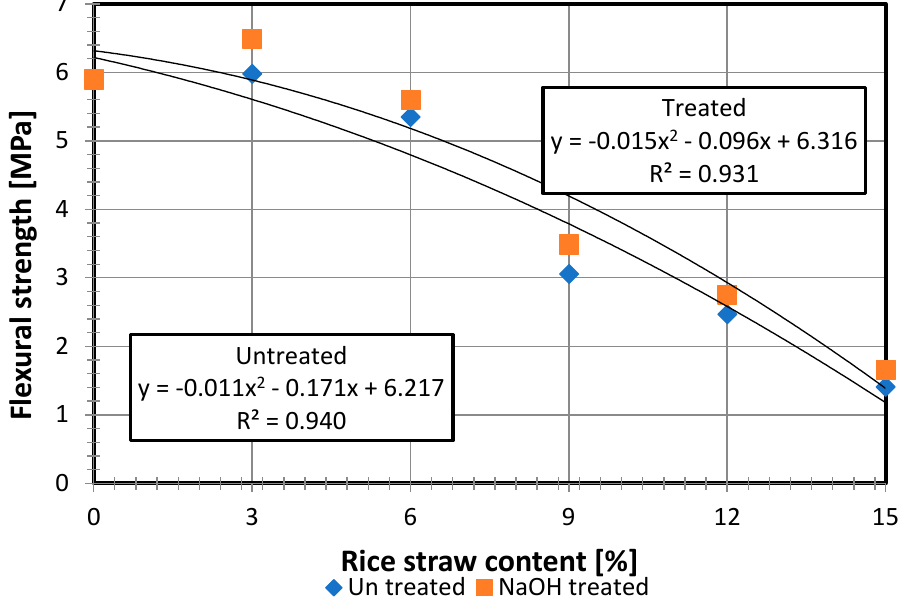
Figure 9. Flexural strength of the treated and untreated rice straw concrete at different percentages of rice straw.